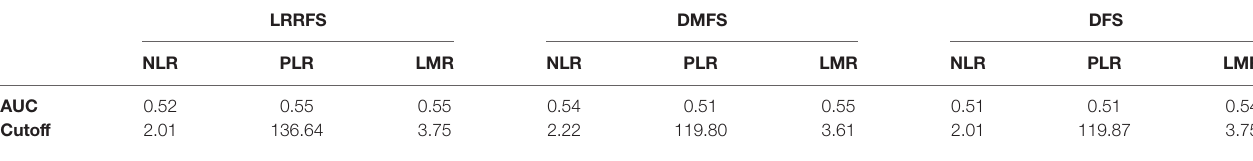
TABLE 3 | Optimal cutoff values of preoperative NLR, PLR, LMR for prediction of 5-years LRRFS, DMFS, DFS in ER+ HER2- early breast